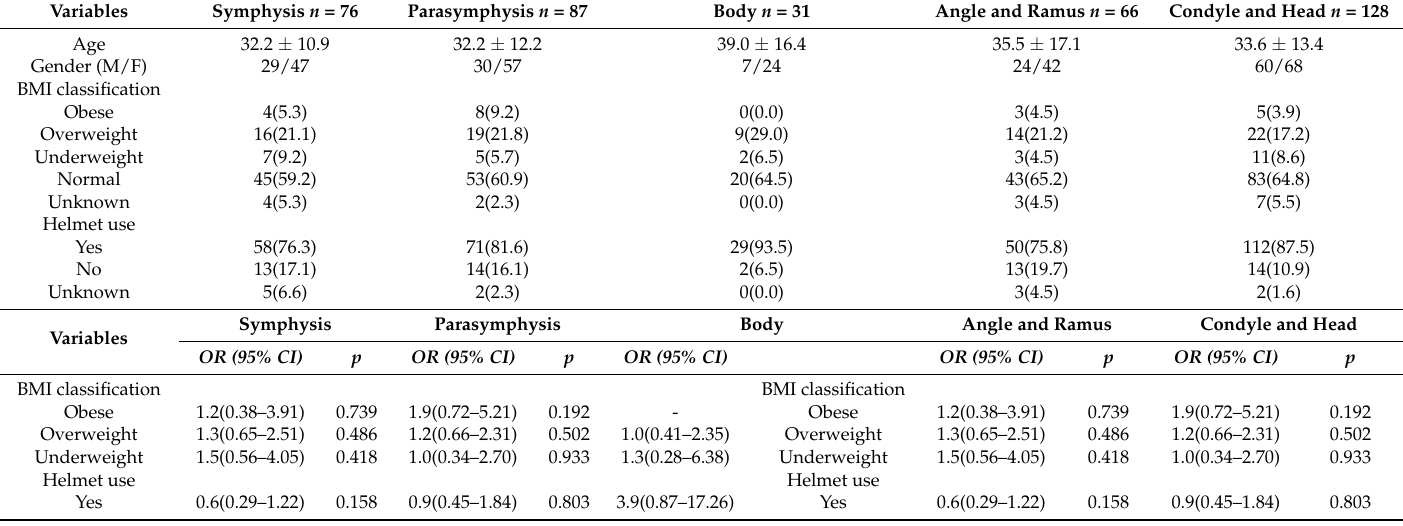
Table 3. The association between helmet use and body mass index (BMI) in motorcycle accidents and sites of mandibular